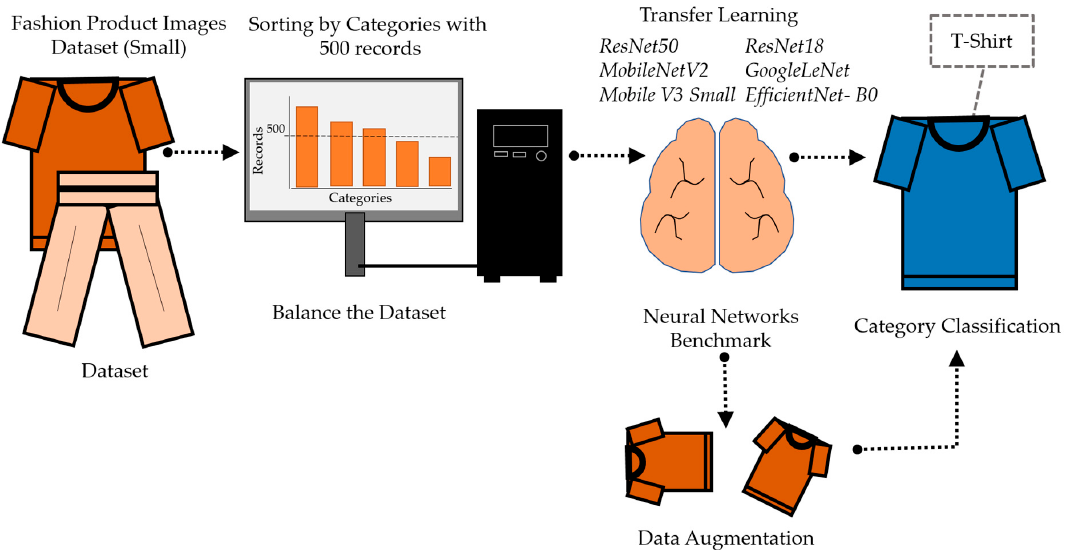
Figure 1. Workflow methodology for the classification of clothing categories.